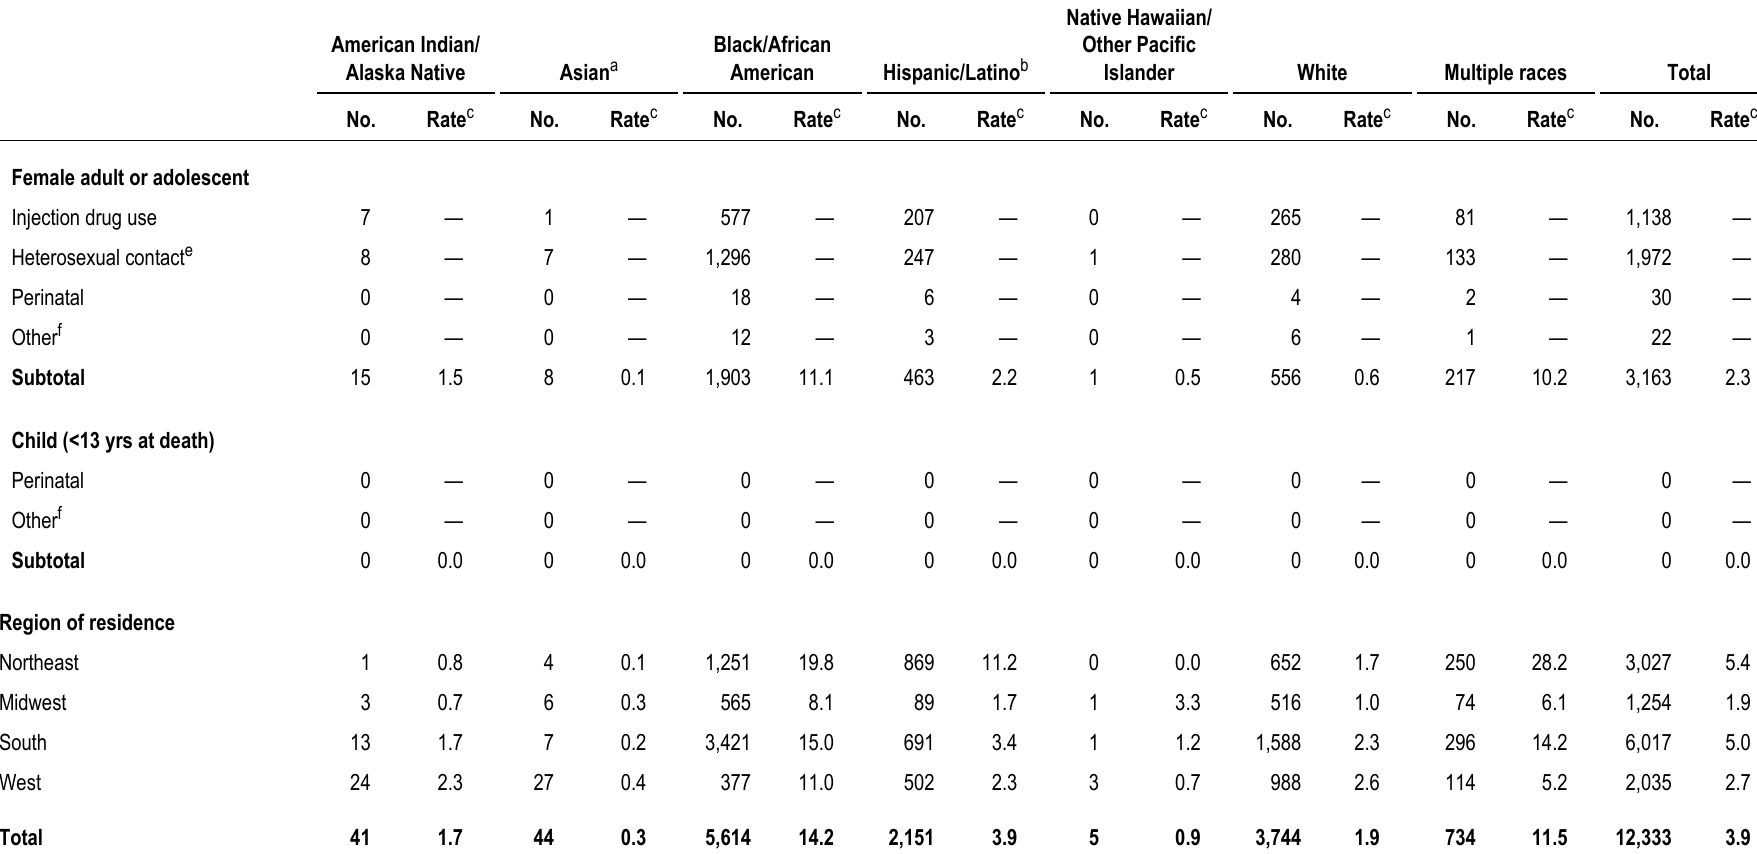
Table 15a. Deaths of persons with diagnosed HIV infection ever classified as stage 3 (AIDS), by race/ethnicity and selected characteristics, 2014—United States